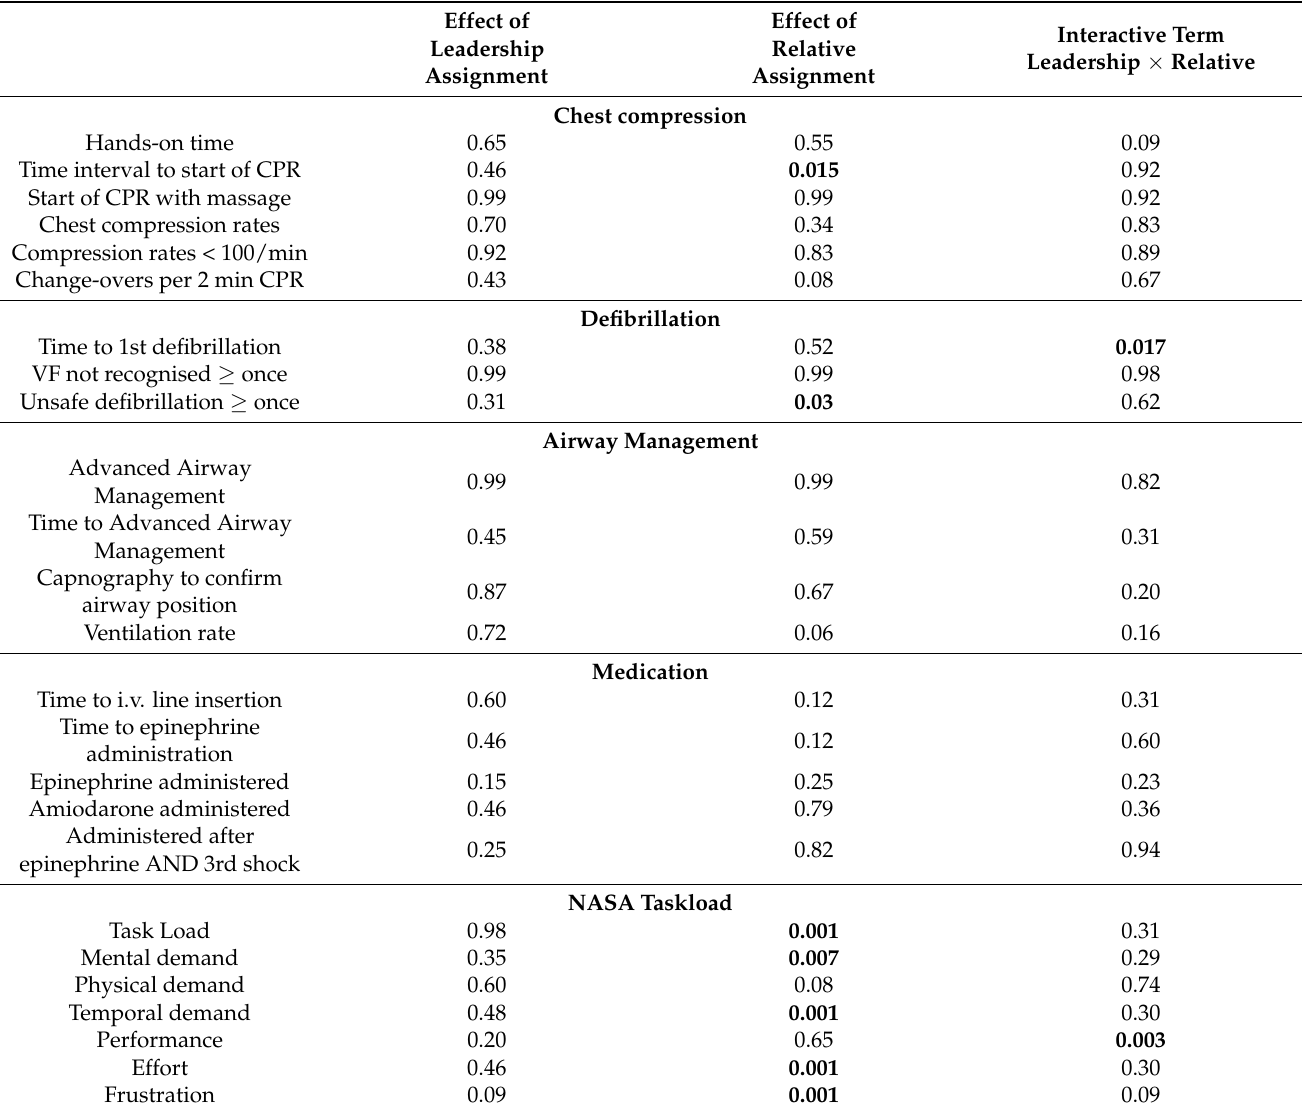
Table 3. Effects of leadership